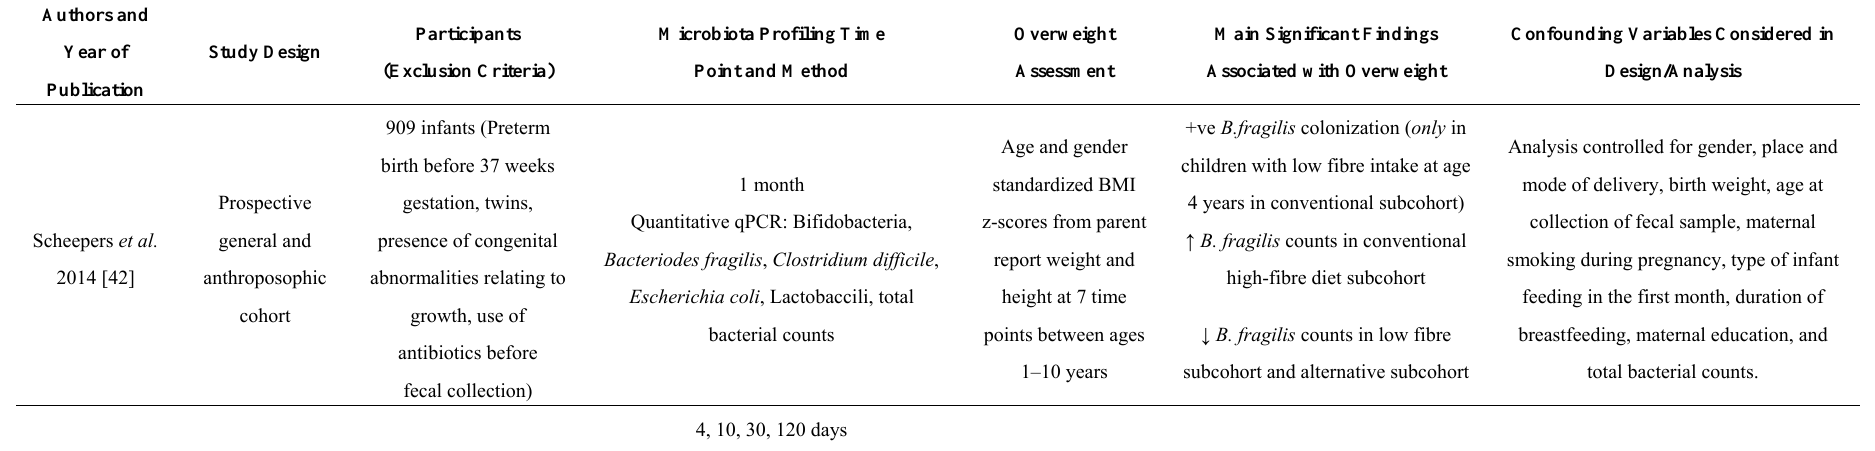
Table 1. Associations between gut microbial community and infant overweight